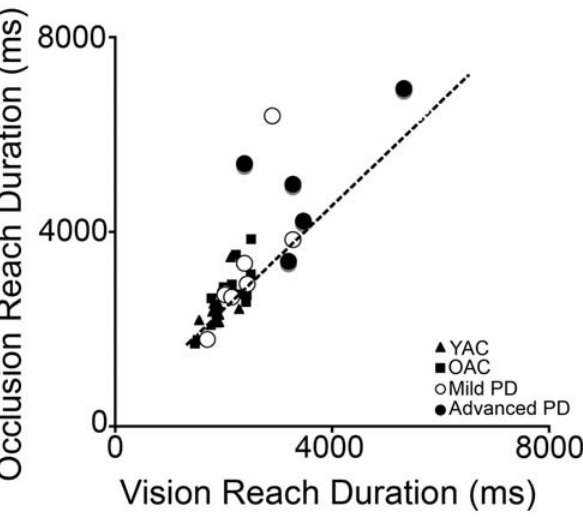
Figure 8. Correlation between total reach duration with vision and total reach duration with occlusion. The line represents the regression of the control groups. Note the disproportionate increase in duration for some PD subjects.